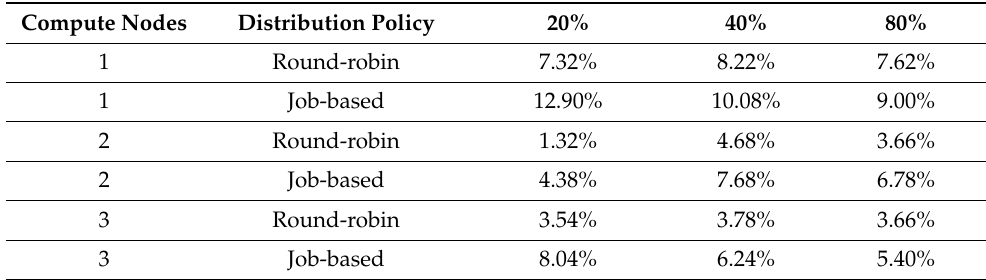
Table 3. Reduction in execution time in percentage of the round-robin and job-based distribution methods with respect to the batch-based